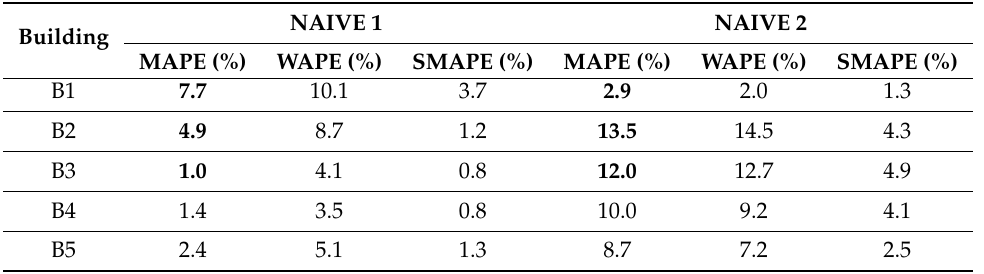
Table 10. Improvement in terms of prediction error reduction of the artificial neural network model